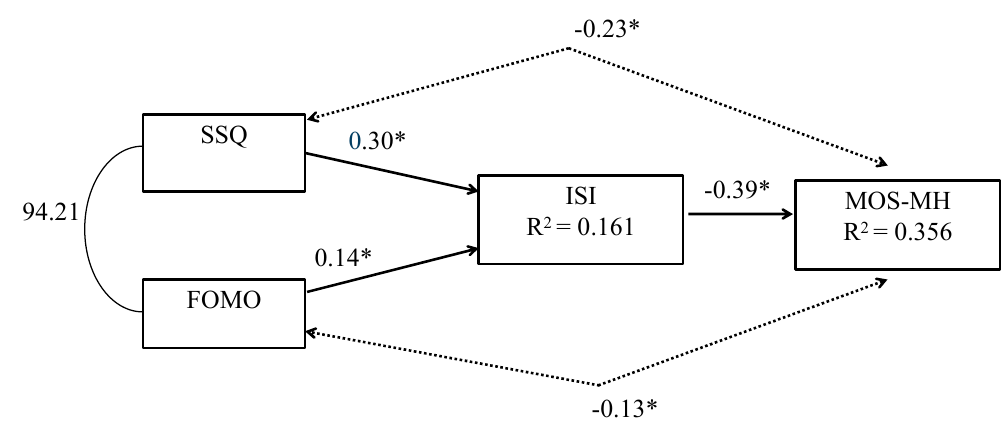
ffi cients and R 2 values for full model, * significant at the 0.05 Figure 1. Standardized path coefficients and R 2 values for full model, * significant at the 0.05 level. Figure 1. Standardized path coe